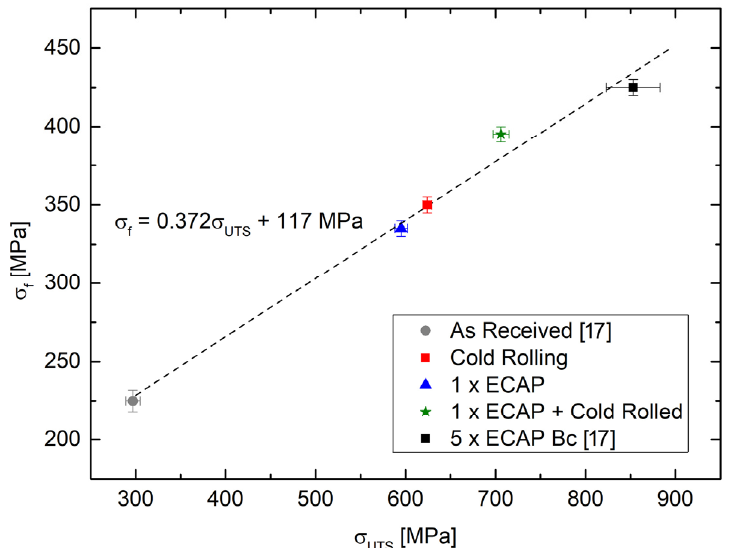
Figure 6. Endurance limit ( σ f ) for rotating bending fatigue as a function of ultimate tensile strength ( σ UTS ) for ARMCO ® iron in different processing conditions. The error bars indicate the uncertainty in the determination of σ f and the scatter range for σ UTS from tensile tests.